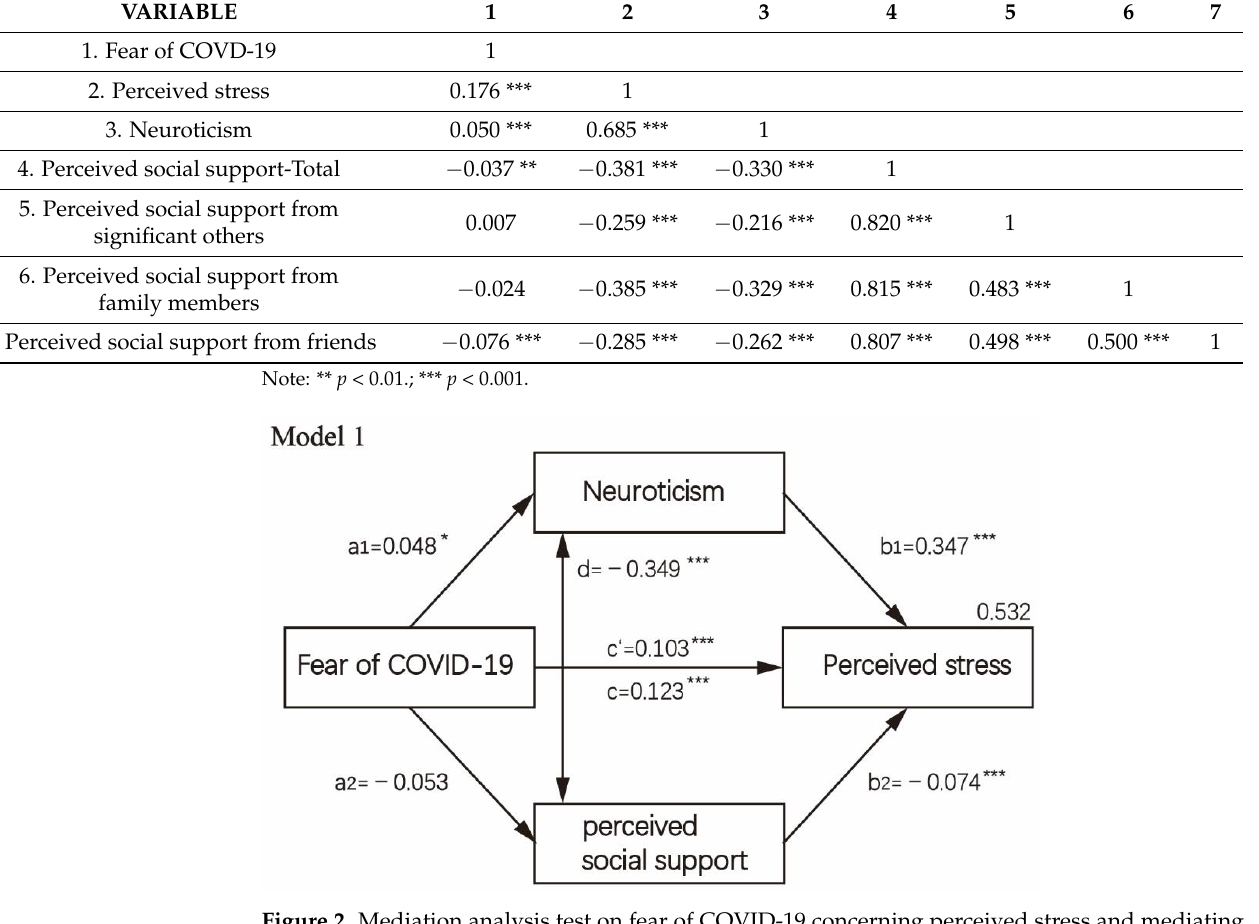
Figure 2. Mediation analysis test on fear of COVID-19 concerning perceived stress and mediating role of neuroticism and perceived social support and controlling covariates, i.e., age, sex, education level, religion, occupation status, history of chronic non-communicable disease and quarantine status ( n = 3299). Note: * p < 0.05; *** p < 0.001.